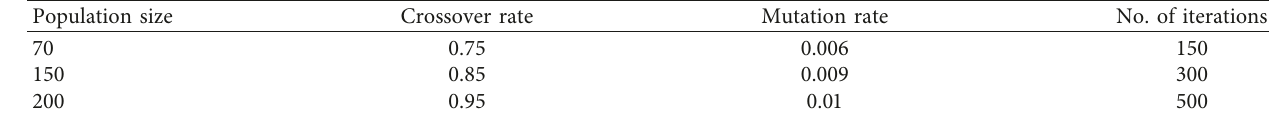
Table 4: GA parameters